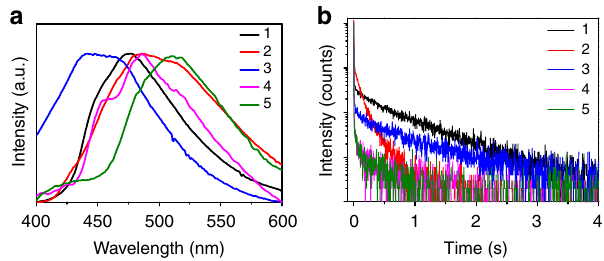
Fig. 5 Photoluminescence properties of a series of materials in an aqueous environment. a Normalised phosphorescence intensity of a series of phosphorescent materials in an aqueous environment. b Lifetime decay pro fi les of a series of phosphorescent materials in an aqueous under 373 nm excitation and was successfully applied in ion detection based on its visible phosphorescence. Phosphorescence detection more effectively eliminates the fl uorescence background